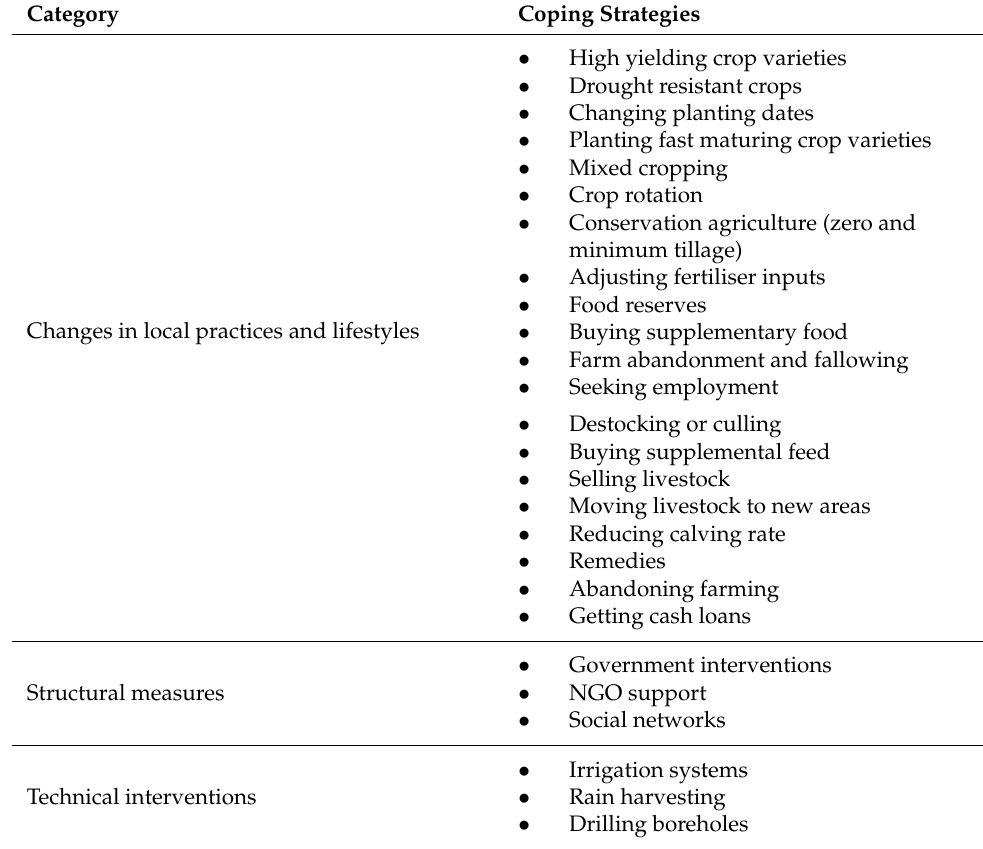
Table 2. Reported drought coping